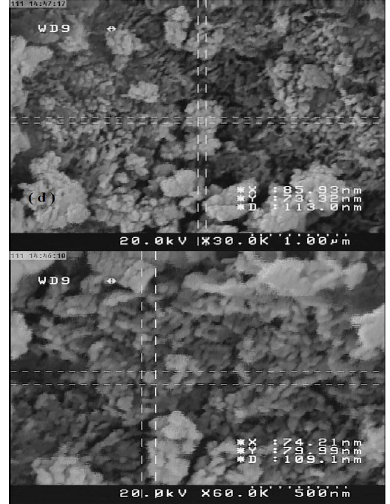
Fig. 6. SEM image of ZnS/ZnO nanoparticles by TU Fig. 7. SEM image of ZnS nanoparticles by thiourea and Na